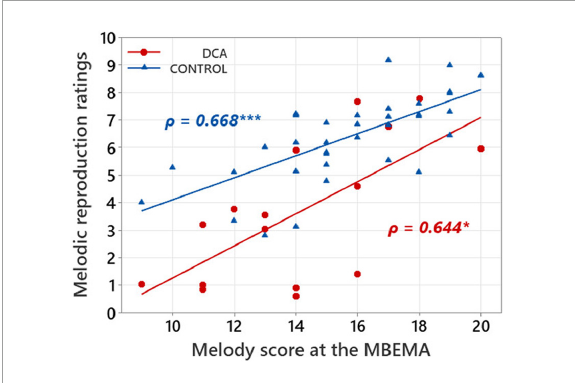
FIGURE3 Scatterplot illustrating the correlations between mean ratings in melodic reproduction task and scores on the MBEMA Melody subtest. Regression lines are fitted for each group and the Spearman’s ρ are indicated. ∗ p < 0.05 and ∗∗∗ p < 0.001.